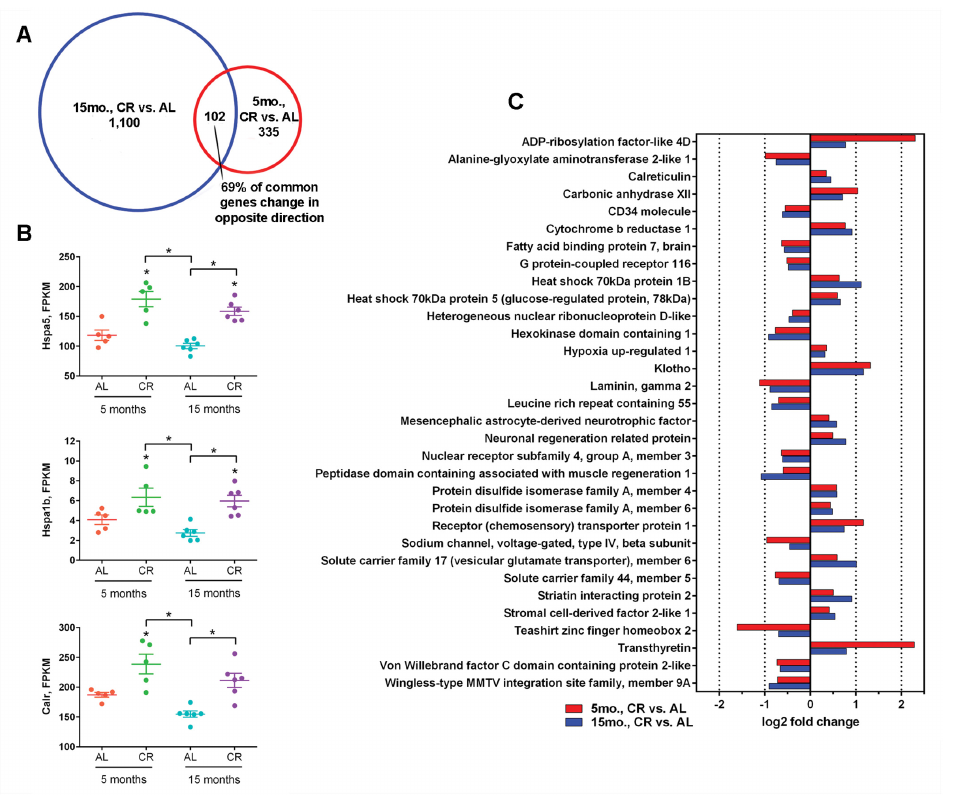
Fig 5. CR upregulation of neuroprotective gene signatures is conserved at 5 and 15 months, despite divergent transcriptional profiles. (A) 102 genes are common to both the 15 and 5 month CR vs. AL differential expression mRNA sequencing profiles. Of the 102 common genes, 70/102 (69%) of significant changes occur in the opposite direction. (B) Normalized age- and diet-dependent FPKM levels for select protein folding and calcium buffering genes ( * p < 0.01, q < 0.05); heat shock 70 kDa protein 5 (Hspa5), heat shock 70 kDa protein 1B (Hspa1b), calreticulin (Calr). (C) Log 2 fold change levels for the 32 conserved gene expression changes within 15 (blue) and 5 (red) month CR vs. AL expression profiles that occurred in the same direction are depicted (p < 0.01, q <